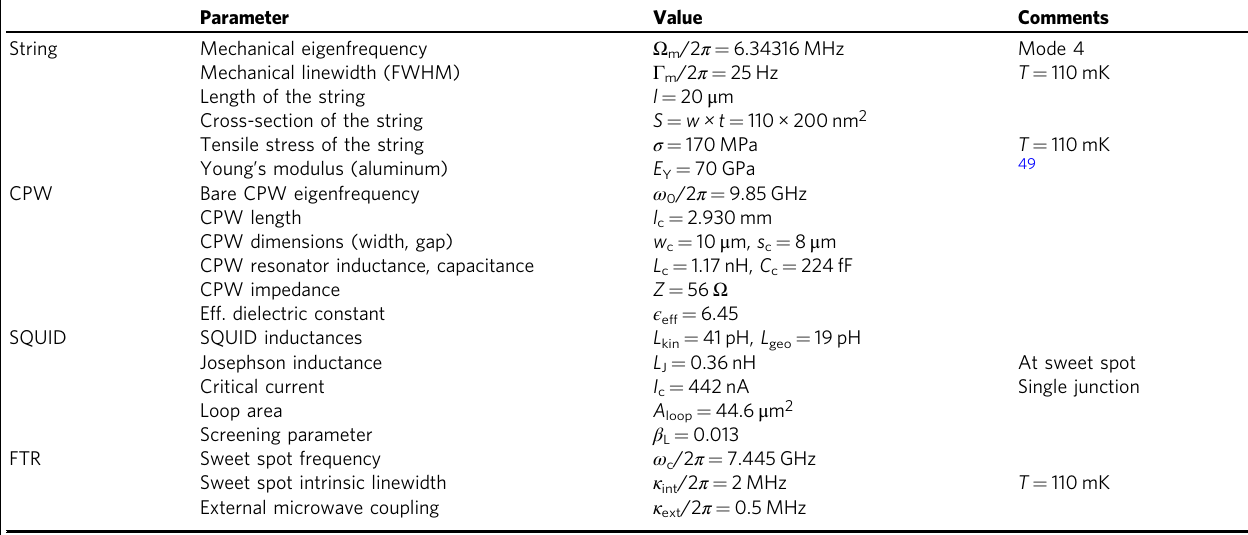
Table 1 Summary of all sample